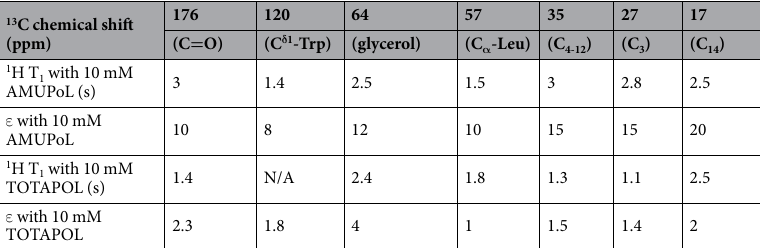
enhancement afforded by DNP spectroscopy at cryogenic temperatures can overcome both the interference with molecular motions and the low sensitivity. In the DNP experiments presented here, samples were prepared with two different DNP polarizing agents, AMUPol 63 and TOTAPOL 64 , as described in the Materials and Methods sec- tion. In order to evaluate the polarizing efficiency of these two different biradicals, one-dimensional 13 C CPMAS NMR spectra 71 of selectively 13 C-labeled cytochrome b 5 embedded in DMPC MLVs were recorded with and without microwave irradiation, as shown in Fig. 1(A and B). These spectra indicate that the high efficiency of the DNP effect and the suppressed molecular motions at frozen conditions both contribute to excellent sensitivity enhancements of these CPMAS spectra. On the other hand, the undesired line-broadenings in the spectra were also observed because of restricted molecular motions and/or the conformational heterogeneity at cryogenic temperatures, as discussed in previous studies 70, 72 . However, the 13 C chemical shift resonances from the selec- tively labeled sites of proteins do not overlap significantly with the DMPC lipid bilayers or glycerol 13 C signals due to the careful choice of the labeling sites, which results in highly resolved and well dispersed 13 C resonances. Particularly, Trp (indole ring-2- 13 C) resonances around 125 ppm are completely isolated from other signals from protein, glycerol and lipid (Fig. 1A). As shown in Fig. 1 and Table 1, our experiments yielded DNP enhancement factors ( ε ) of ~20 and ~3.6 with 10 mM AMUPol and 10 mM TOTAPOL, respectively. These DNP enhancements of AMUPol and TOTAPOL are comparable with previously reported values on non-crystalized membrane proteins in lipid bilayers 56, 58, 60, 73 . Remarkably, AMUPol produced higher DNP enhancement for all of the 13 C resonances, with an average of about